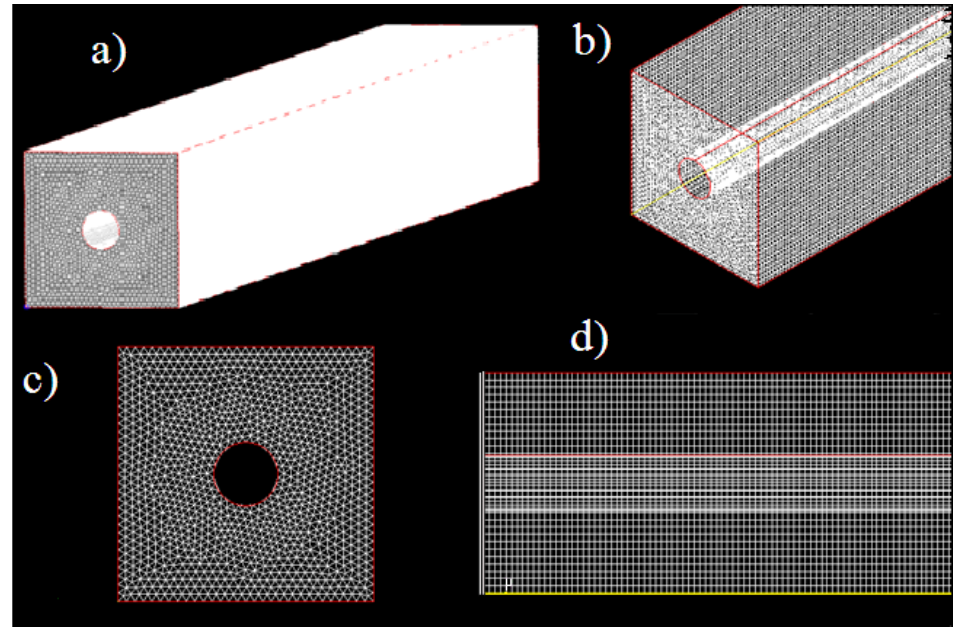
Figure 3. 3D model for the differential storage element, with grid: ( a ) overall view; ( b ) isometric view; ( c ) frontal view; and ( d ) lateral